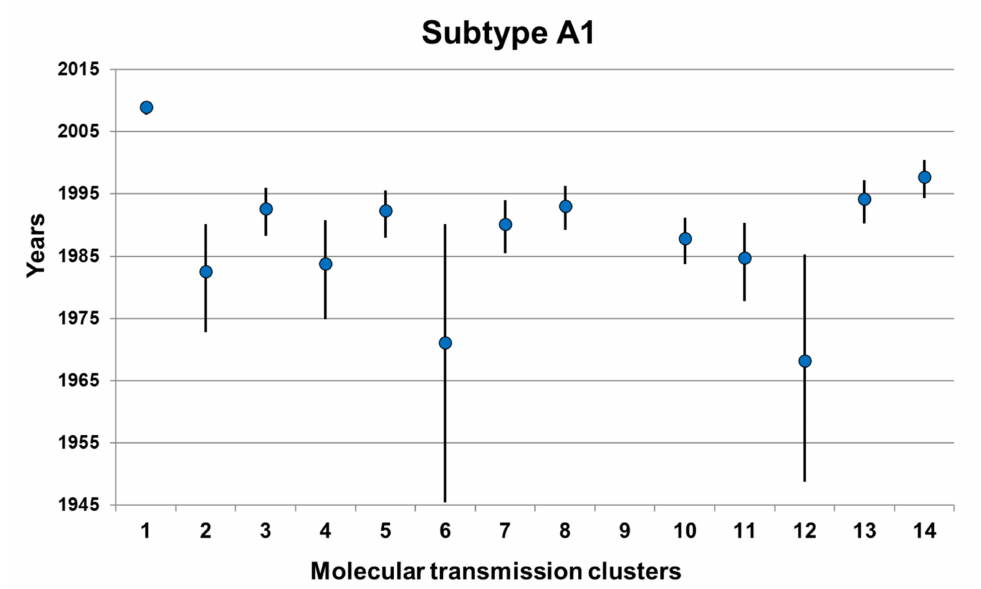
Figure 1. Molecular clock calculations of the time of the most recent common ancestor (tMRCA) for the 14 HIV-1 subtype A1 molecular transmission clusters (median, 95% HPD interval) where no cut-off was implemented for the proportion of the ARV-treated PLHIV within a cluster. Dots indicate the median estimations and horizontal lines the 95% HPD